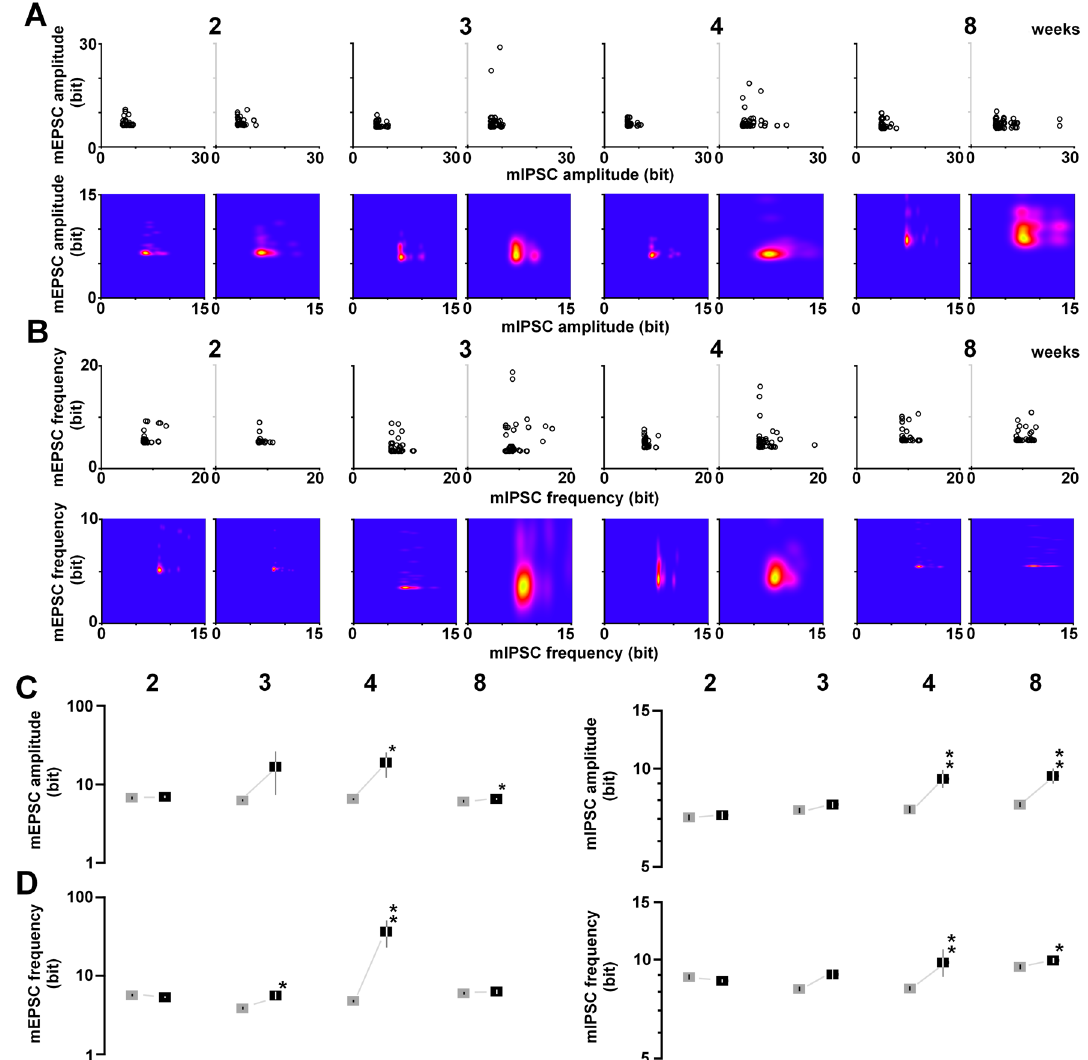
Figure 3. Postnatal development of the gained self-entropy in individual neurons. ( A ) By calculating the appearance probability of individual dots in mEPSC and mIPSC amplitudes, we calculated the self-entropy (bits) of individual neurons (upper), and visualized the kernel density distribution (lower). ( B ) The same process as in ( A ), applied for mEPSC and mIPSC frequencies, showing the self-entropy (bit) of individual neurons (upper) and the visualized kernel density distribution (lower). ( C ) Postnatal changes in the mean self-entropy of mEPSC (left) and mIPSC (right) amplitudes in untrained (gray) and trained (black) rats. The IA task increased the self-entropy at 4–8 weeks. A base 10 log scale is used for the Y axis. ( D ) Postnatal changes in the mean self- entropy of mEPSC (left) and mIPSC (right) frequencies. The IA task increased the self-entropy of mEPSCs (left) at 3–4 weeks, and that of mIPSCs (right) at 4–8 weeks. The numbers under the graphs indicate the number of neurons. The error bars indicate ± SEM. * P < 0.05, ** P < 0.01 vs.